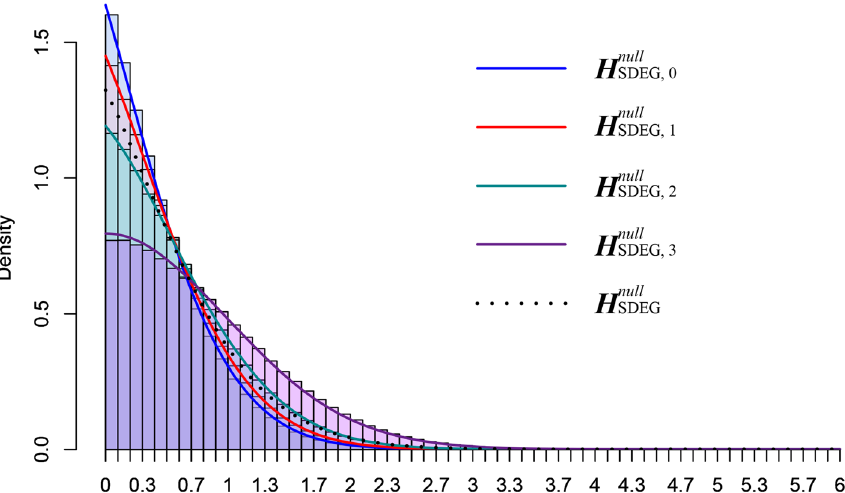
Figure 7. Mixture null distribution of OVE-sFC test statistic for detecting SDEGs. The mixture distribution consists of ( K − 1 ) null components, each estimated from the resamples after randomly permuting samples in the top ( K − m ) subtypes of high mean expressions and weighted by the posterior probabilities of component null